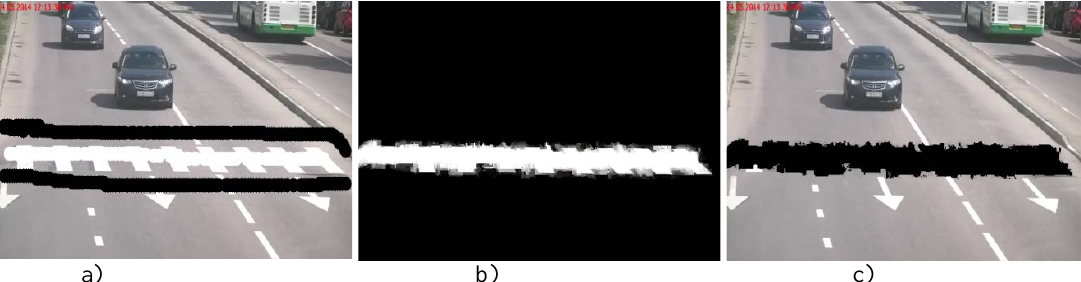
Fig. 8. Stages of segmentation of a zebra: a) marking of an object and background on the first shot, b) an alpha the channel of the image, c) the allocated object